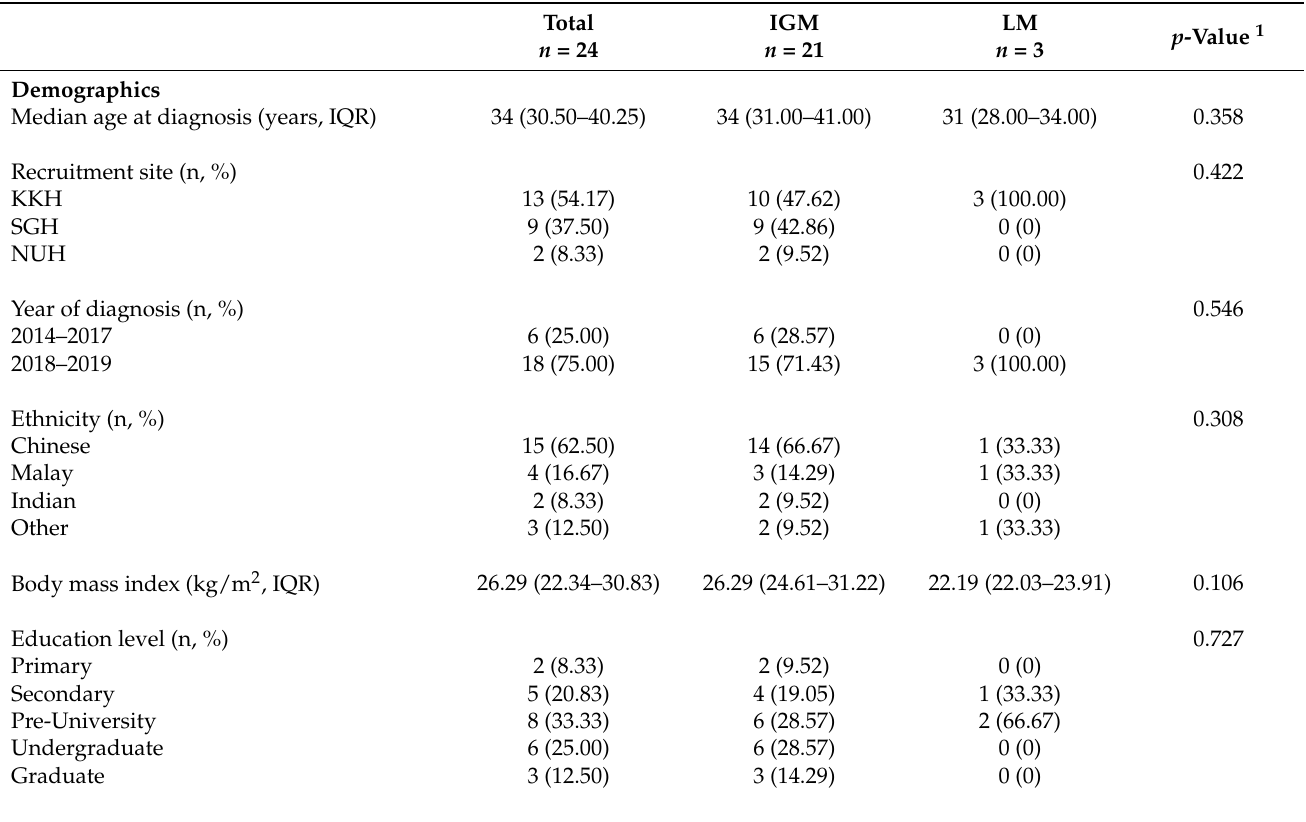
Table 1. Description of analytical cohort of idiopathic granulomatous mastitis (IGM) and lactational mastitis (LM)